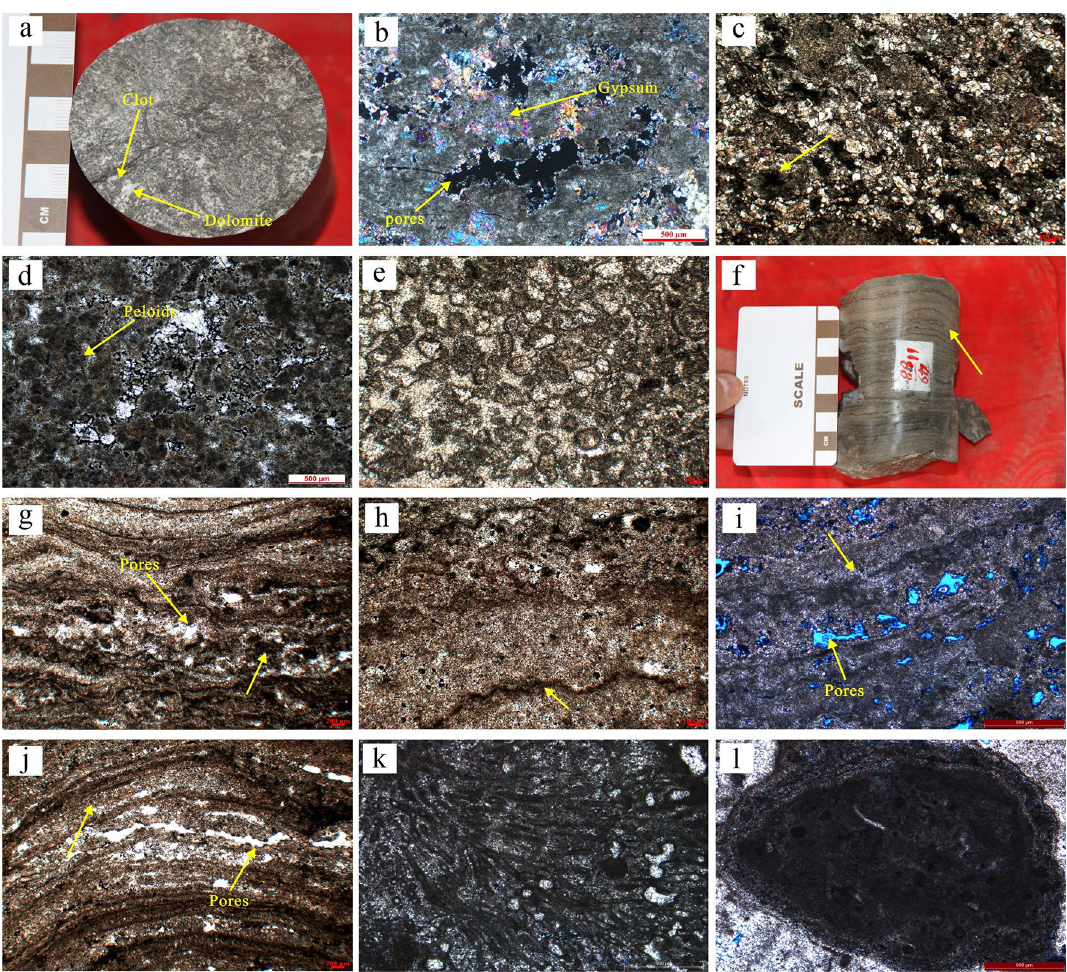
Figure 3. Macroscopic and microscopic characteristics of microbial carbonates in the Leikoupo Formation in Western Sichuan Basin. ( a ) Thrombolites, T 2 l 4 3 , Well LS-1, 5985.20 m; ( b ) densed micrite thrombolites (DMT), T 2 l 4 2 , Well TS-1,5843.80 m; ( c ) porphyritic micrite thrombolites (PMT)(yellow arrow), T 2 l 4 3 , Well MJ-1, 6169.00 m; ( d ) Peloidal-aggutinated thrombolites (PAT), T 2 l 4 3 , Well YS-1, 6235.90 m; ( e ) Foam laminated thrombolites (FLT), T 2 l 4 3 , Well MJ-1, 6200.62 m; ( f ) Undulated lamina in stromatolites, T 2 l 4 3 , Well LS-1, 5996.50 m; ( g ) Agglutinated thrombolitic stromatolites (ATS) (yellow arrow), T 2 l 4 3 , Well YiS-1, 5886.80 m; ( h ) Laminated fine-grained agglutinated stromatolites (LFAS) (yellow arrow), T 2 l 4 3 , Well YiS-1, 5891.28 m; ( i ) Spongiostromate stromatolites (SS) (yellow arrow),